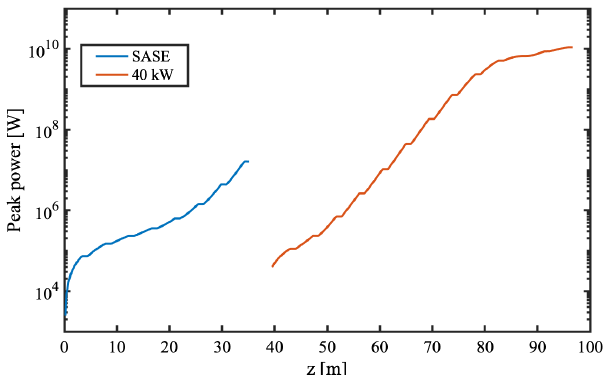
FIG. 5. Power evolution of 1 keV x-rays during SXRSS at LCLS-II. Here and throughout this paper the SXRSS infra- structure is modeled in the slot 34 location.